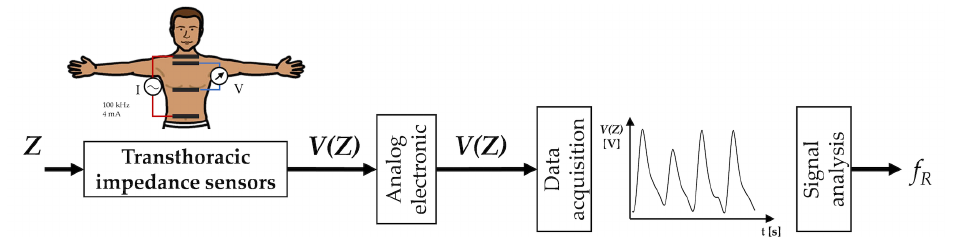
Figure 8. Impedance sensors: the main elements composing the measuring chain (sensor, analog electronics, data acquisition, post-processing or signal analysis stage) to estimate f R . V ( Z ) is the voltage output caused by impedance ( Z )